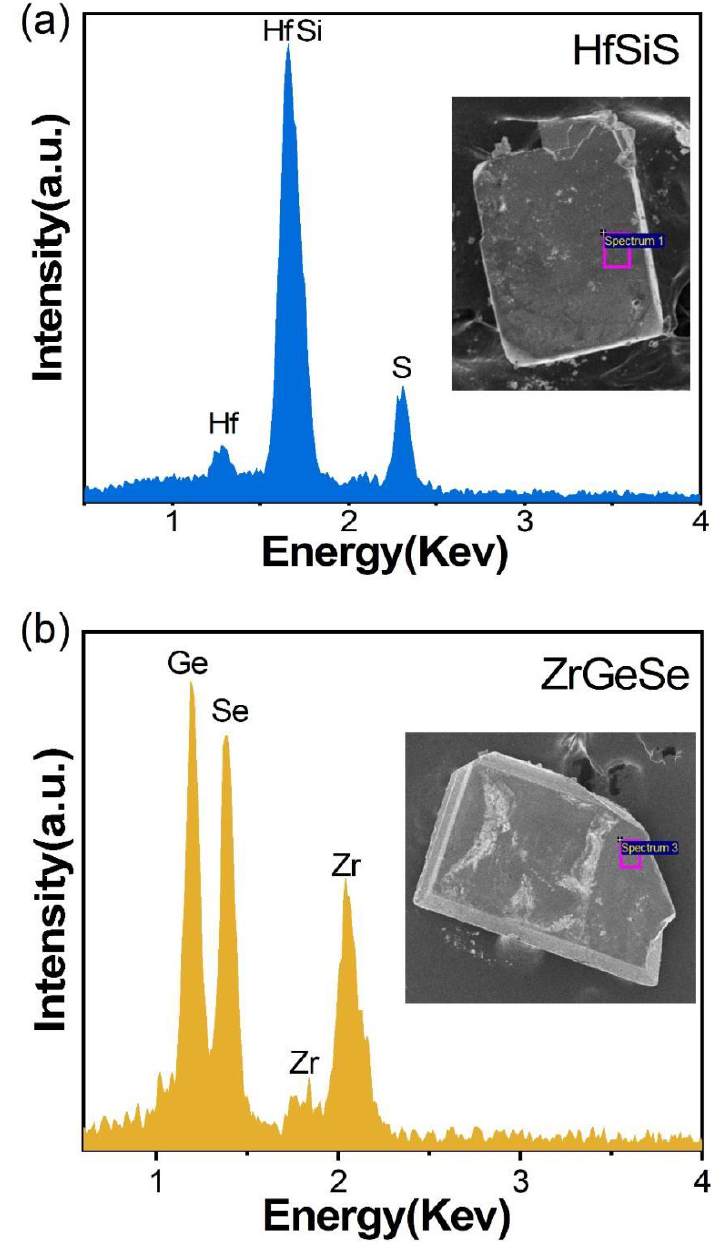
Figure 3. EDS of HfSiS ( a ) and ZrGeSe ( b ). The inset of each panel shows SEM images for both crystals. The pink rectangular box indicates the area for taking EDS